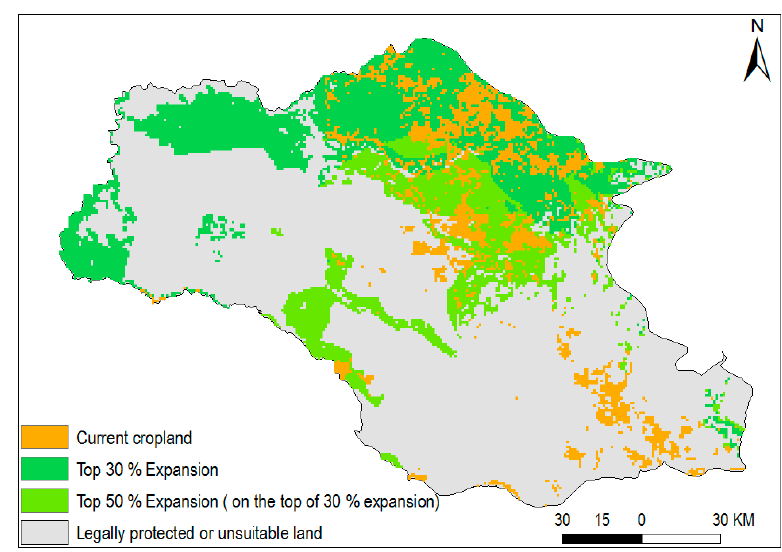
Figure 5. The total area coverage of current cropland, TOP 30 and TOP 50 land use scenarios and legally protected area in the Gambella Region.